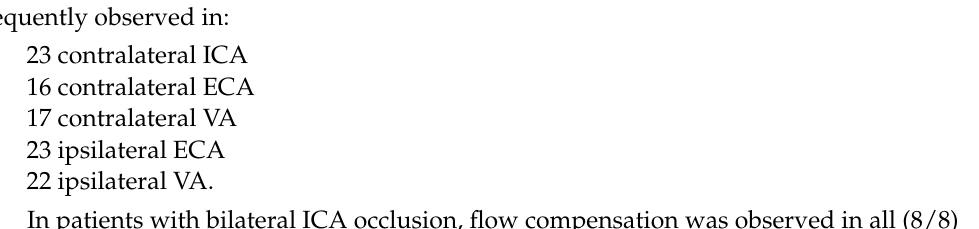
- - - - Table 6. Pathways of collateral circulation in patients with bilateral ICA occlusion.